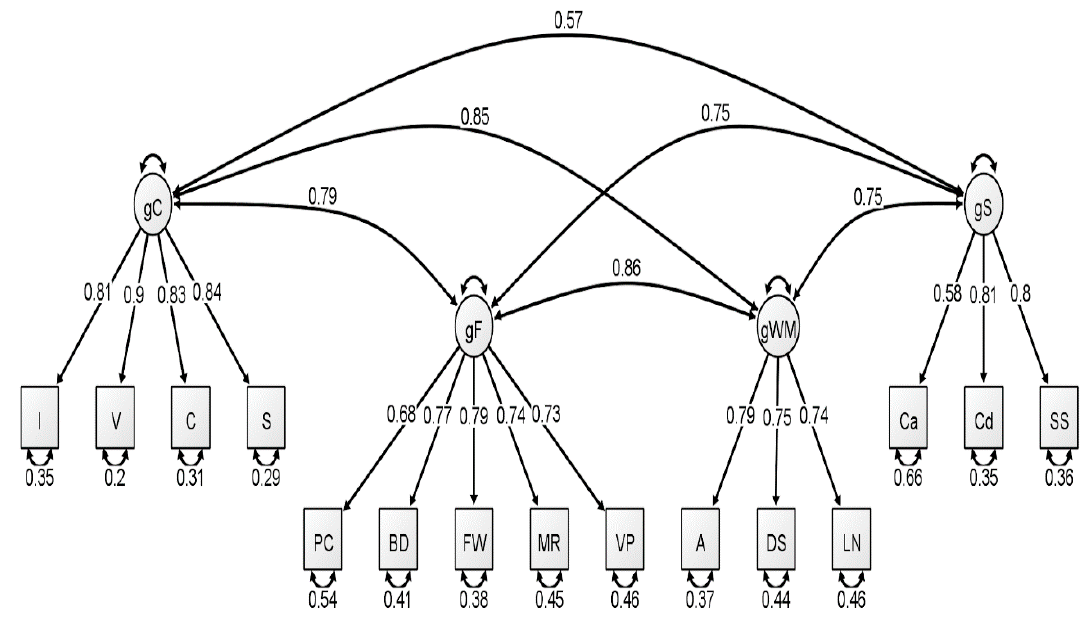
Figure 3. Correlated four-factor measurement model of the older group WAIS-IV correlation matrix. All values are standardized from the confirmatory factor analysis conducted using lavaan. Figure generated using Ω nyx. gC = crystallized